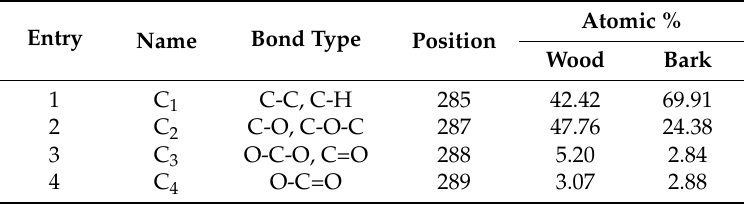
Table 1. Comparative XPS between bark and wood of sugar maple.